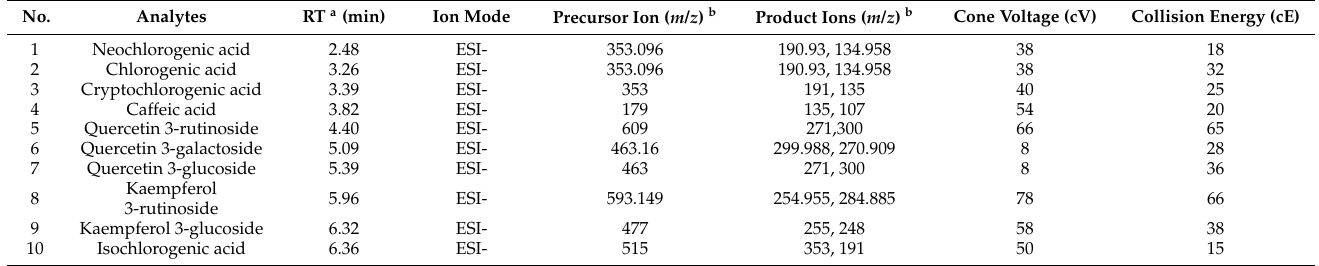
Table 2. Retention time and related MS information of 10 compounds detected on